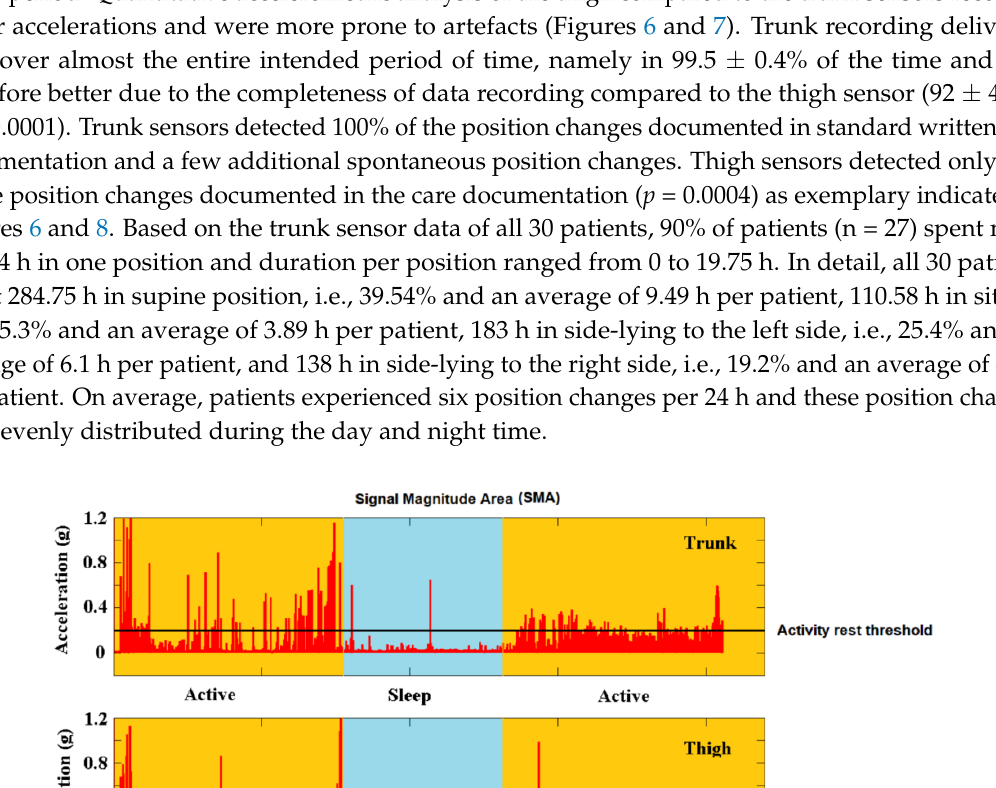
Figure 7. Artifacts of thigh sensors . Visualized accelerations in sagittal axis ( blue ) show artefacts most probably due to spontaneous leg movements, restless legs or spasticity in the cohort of immobile patients suffering from severe neurological diseases such as stroke or traumatic brain injury.